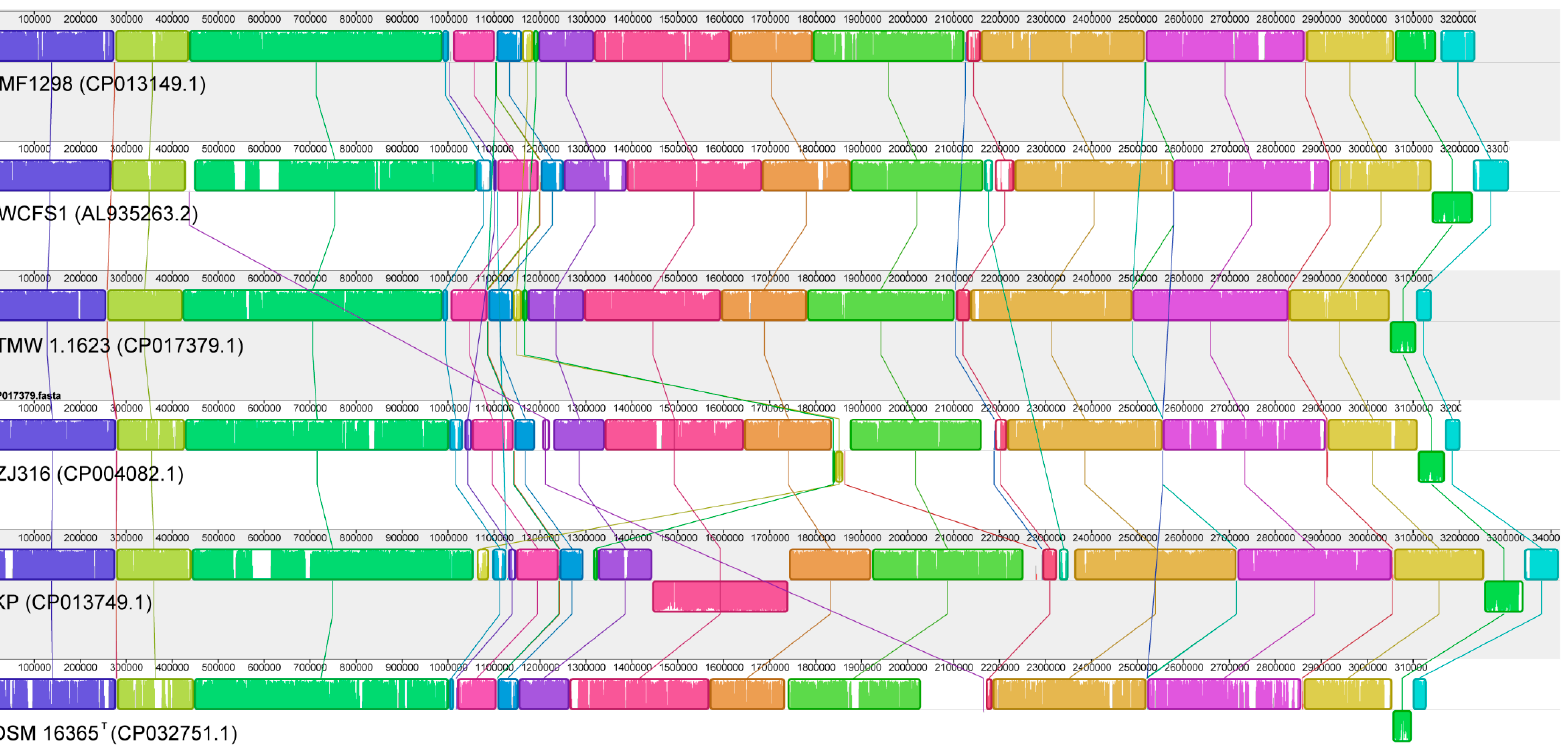
Figure 1. Chromosomal alignment of six Lactobacillus plantarum strains. The alignment was performed using MAUVE software [27] with strain MF1298 set as the reference. Each contiguously colored region is a local collinear block (LCB), a region without rearrangement of homologous backbone sequence. LCBs below the center line of a chromosome are in the reverse complement orientation relative to the reference chromosome. Lines between genomes trace each orthologous LCB through every chromosome. The white areas inside each LCB show regions with low similarities. Regions outside LCBs represent unique regions.